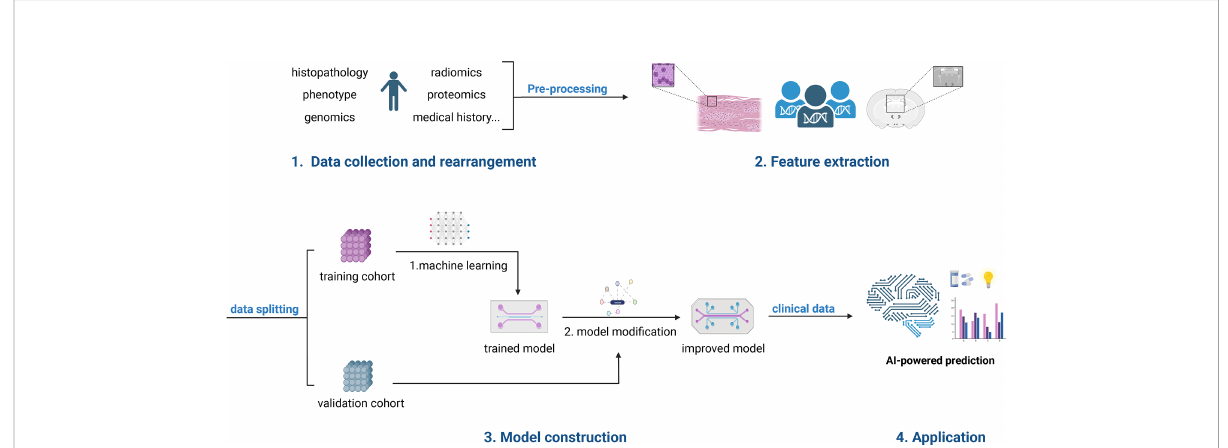
FIGURE 1 The work fl ow for using AI to predict immunotherapy ef fi cacy. The First step is to collect multiscale medical data which include pathological tissue, CT/MR imaging-omics, genomics, proteomics, and more. The following steps are to gather, fi lter, segment, extract and select features. Then split these data into a training cohort and a validation cohort. Next, take the data from the training cohort, handing them over to the AI for learning and modeling. And then utilize the validation cohort to verify the learning results. Finally, a clinically applicable model will be